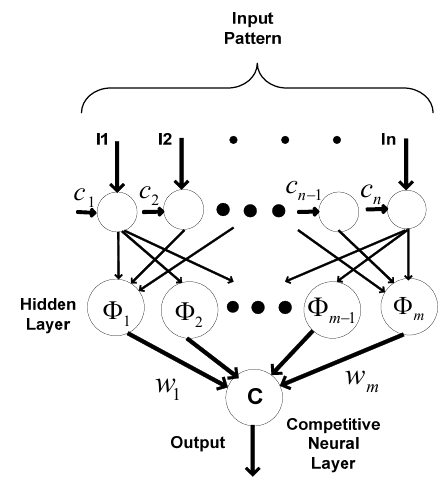
Figure 4. Applied RBF classification